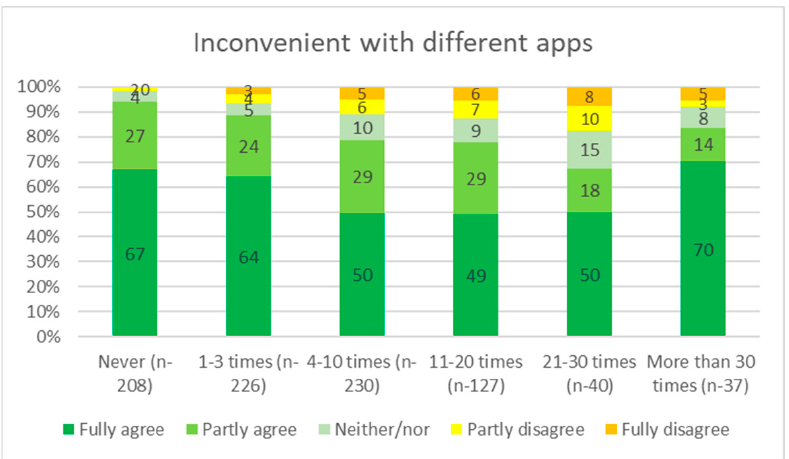
Figure 3. Distribution showing BEV owners’ level of agreement to the statement “ It is inconvenient when charging operators operate with different apps ”, on the basis of the number of times the respondents used public fast chargers the last 12 months ( n -868).